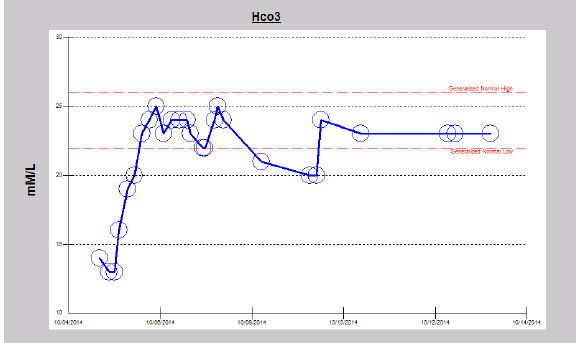
Figure 1. Trajectory of serum bicarbonate during the first 10 days of the admission with intentional ethylene glycol